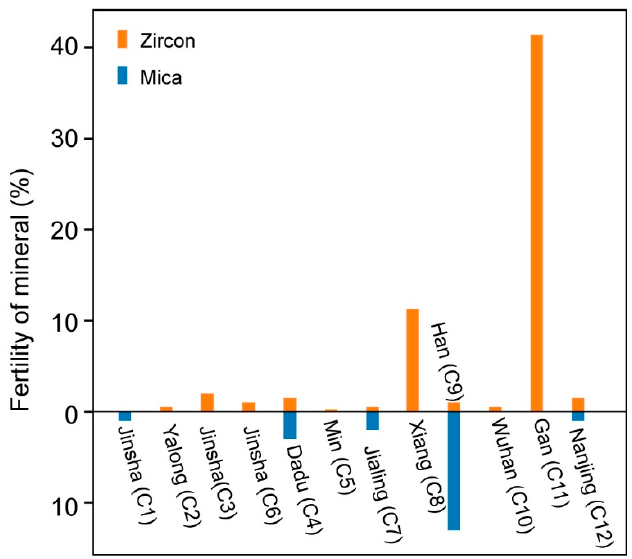
Figure 5. Zircon and mica fertility of major tributaries. Concentration of zircon grains in the heavy mineral fraction. Mica and zircon data from Vezzoli et al. [45].